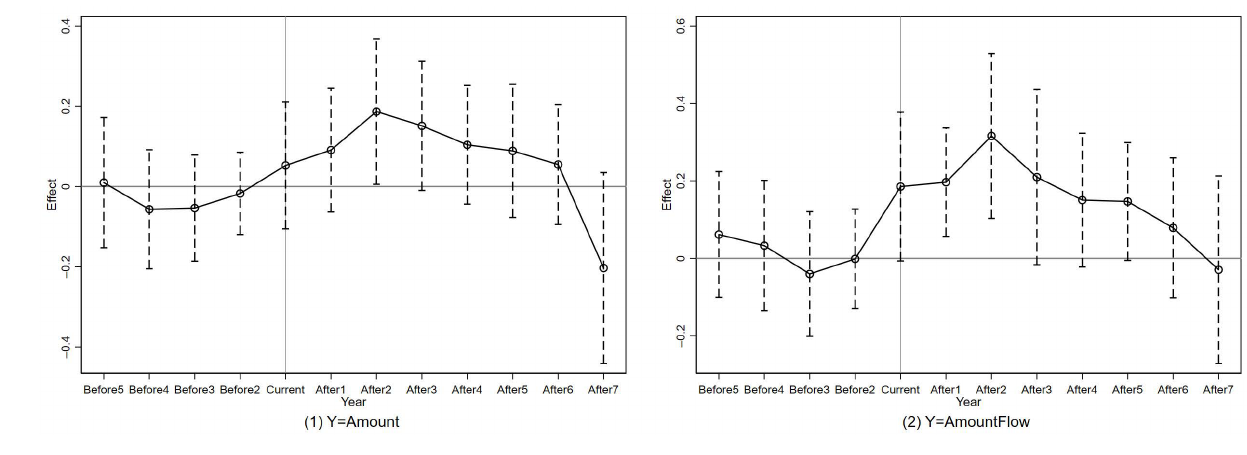
Figure 1. Parallel tests. Table 5. Results of propensity score matching difference in difference (PSM-DID) model. Panel A. Balanced Tests